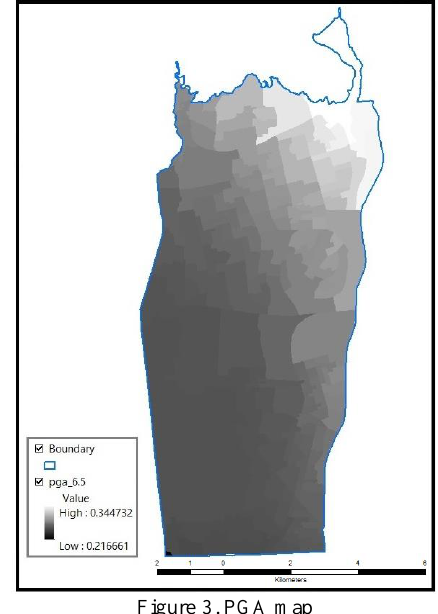
 Number of floors in the building layer: This map shows the number of floors of the buildings in the study area .Figure 4 shows that its range is between 0 floors (the parcels without any building) to 36 floors. The taller the building, the more vulnerable it is.